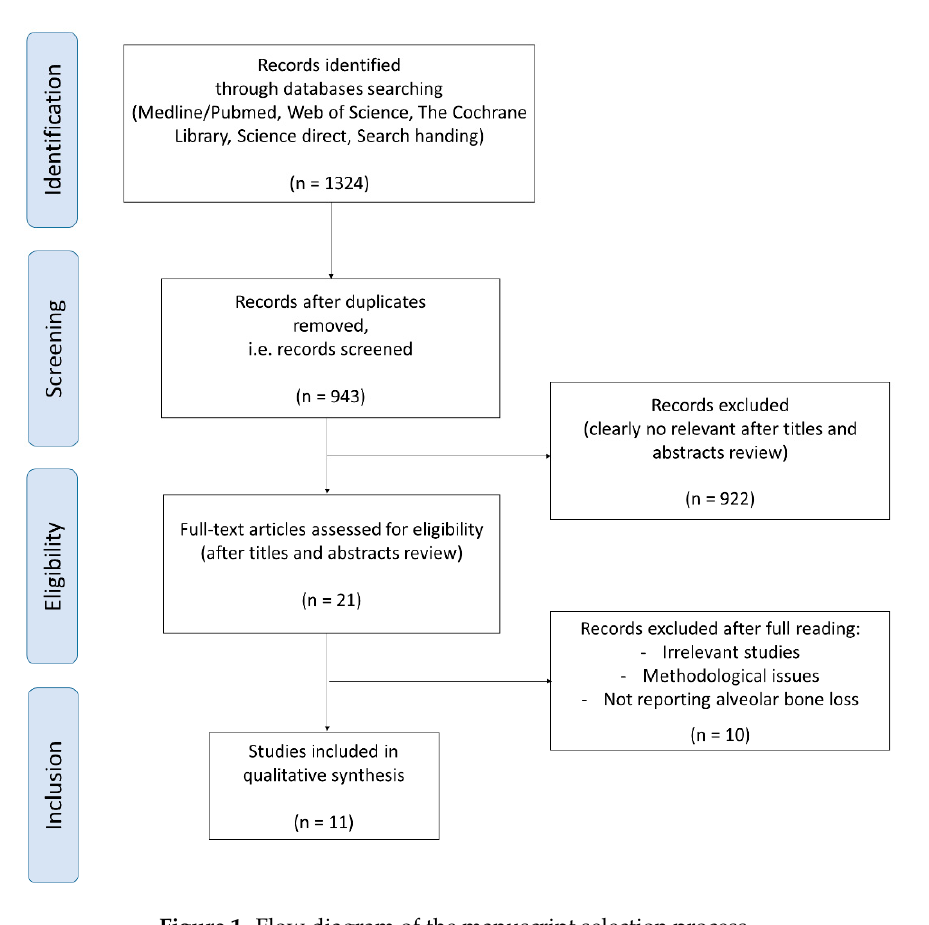
Figure 1. Flow diagram of the manuscript selection process.